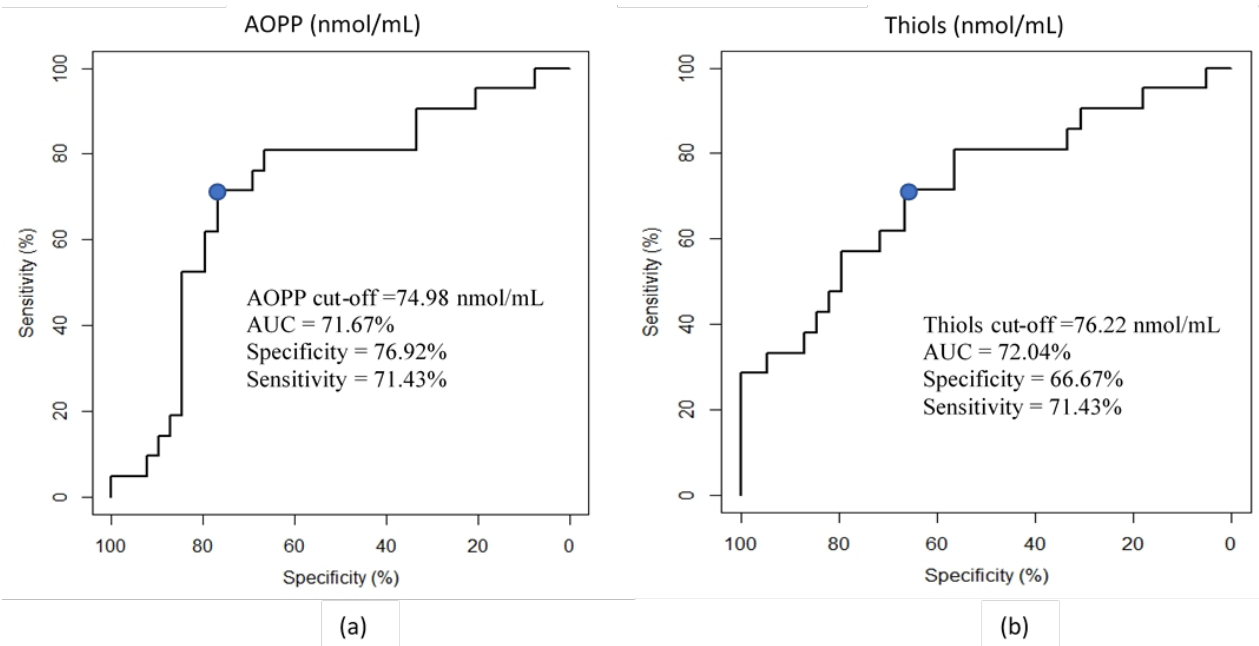
Figure 1. Receiver operating characteristic (ROC) curve analysis for the prediction of motility clusters. ( a ) ROC curve showing the ability of the AOPP concentration (nmol/mL) of seminal plasma (SP) to discriminate the motility of fresh semen (HMF vs. LMF). AUC: area under the curve. The blue dot shows the cut-off of AOPP to predict the motility group (HMF vs. LMF) ( b ) ROC curve showing the ability of the thiol concentration (nmol/mL) of seminal plasma (SP) to discriminate the motility of fresh semen (HMF vs. LMF). AUC: area under the curve. The blue dot shows the cut-off of thiols to predict the motility group (HMF vs. LMF)